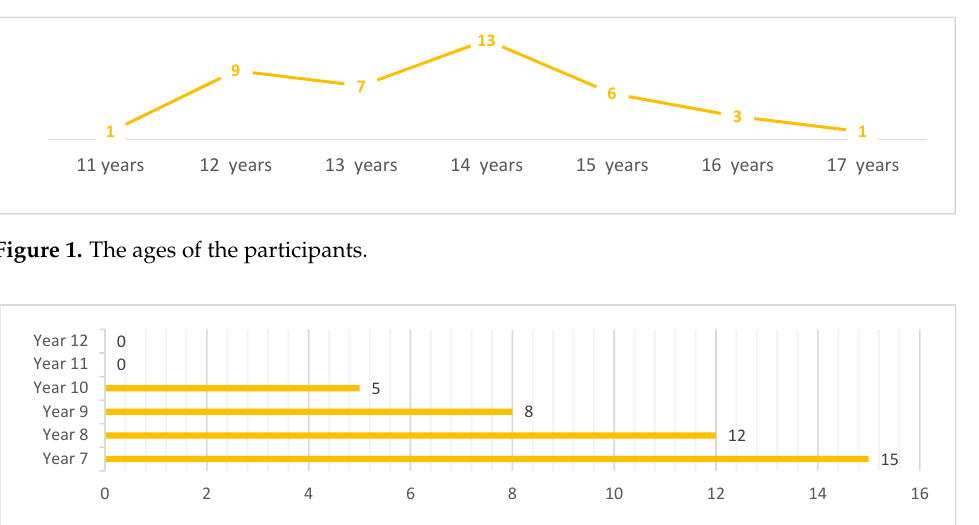
Figure 2. The Year of study the participants were enrolled in.